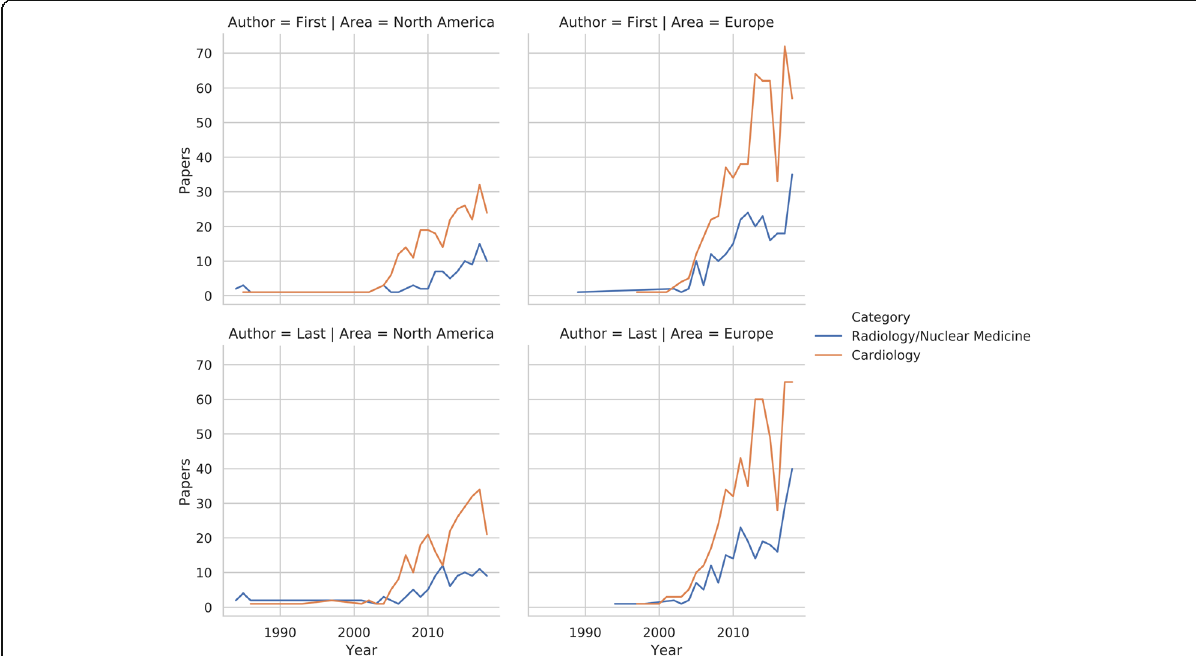
Fig. 3 Line plot depicting the number of studies published by cardiologists or radiologists/nuclear medicine physicians as the first or last authors over the years in Europe and North America